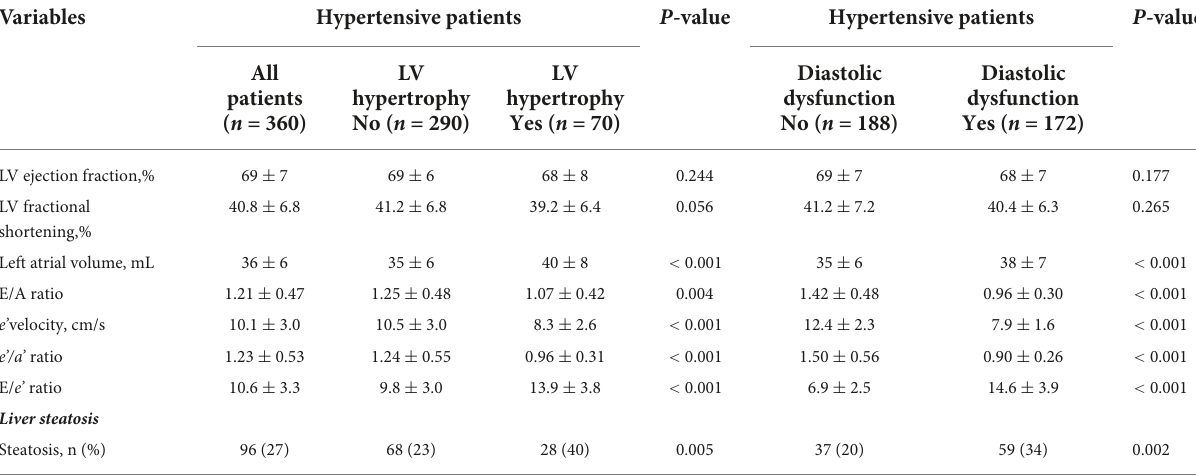
The Kolmogorov-Smirnov test was used to assess normality of distribution of the study variables. Variables with skewed distribution were log transformed. Mean ± standard deviation is used to present normally distributed variables and median and [interquartile ranges] to present skewed variables. Categorical data are presented as absolute number and